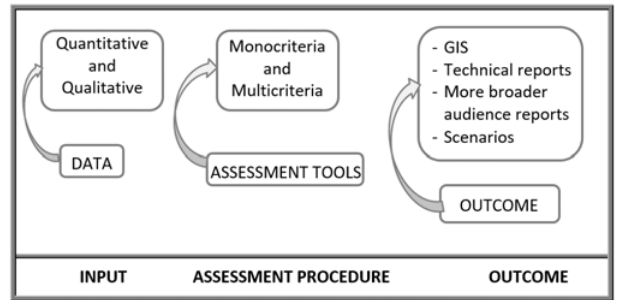
Figure 1. Structure of Decision Support Systems.